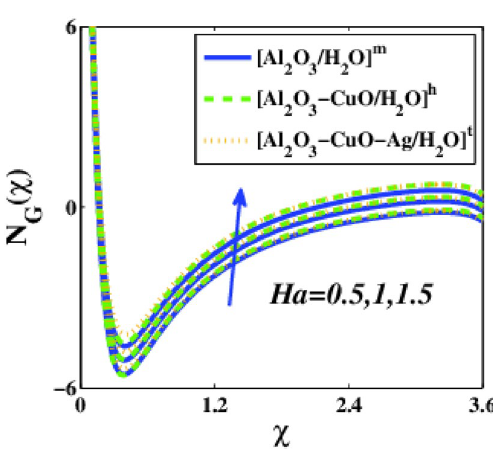
Figure 5. Conclusion of Ha on N G (χ) .